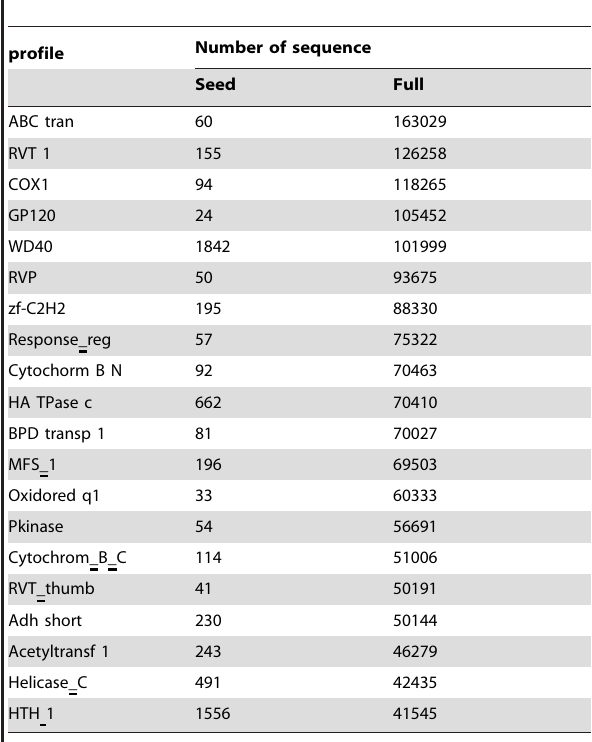
Table 2. Top twenty protein families in pfam